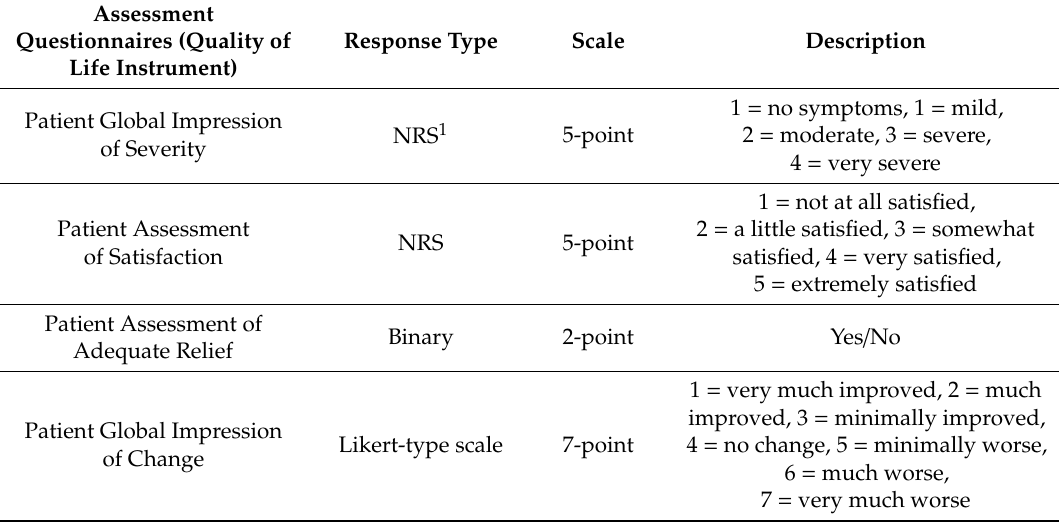
Table 3. Global Patient Assessment